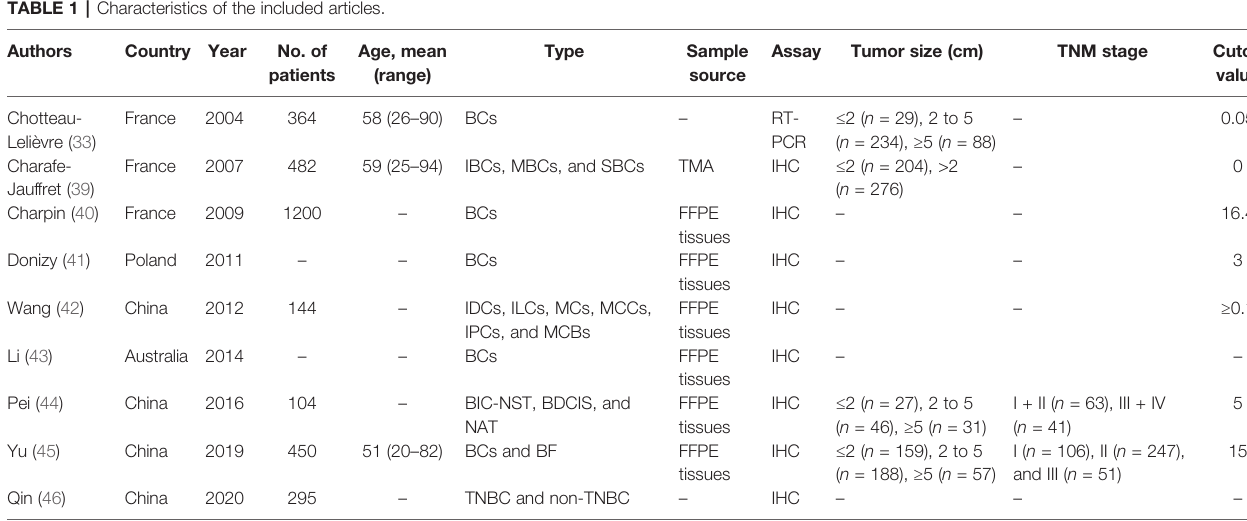
TABLE 1 | Characteristics of the included articles.